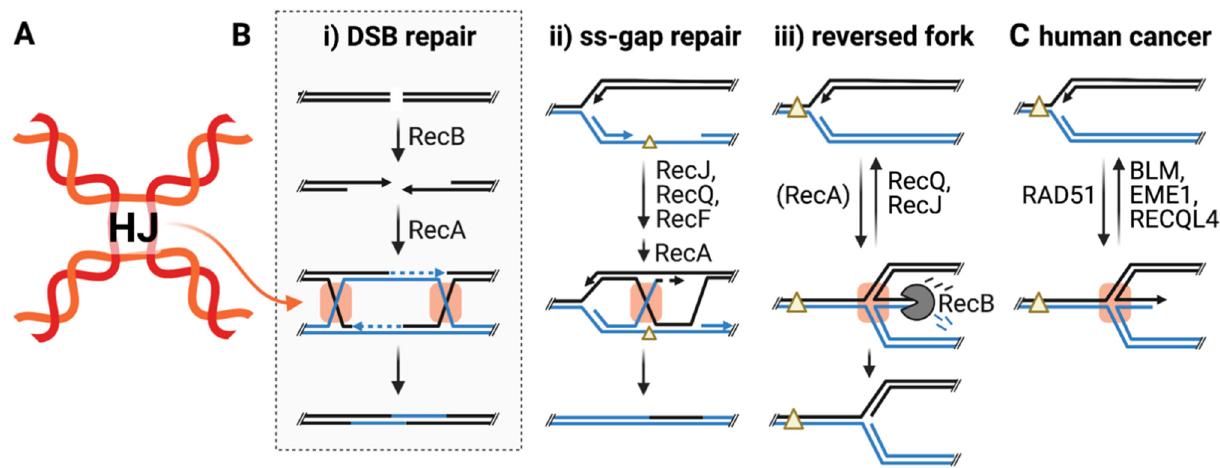
Figure 1. Holliday junction structure and formation. ( A ) An X-shaped Holliday junction (HJ). ( B ) Three pathways of HJ formation, highlighting key components of each pathway. HJs are highlighted by orange boxes. Close parallel lines, base ‐ paired DNA strands; yellow triangles, replication ‐ blocking DNA damage. Gray box indicates HJ ‐ forming pathway at fragile sites. ( i , ii ) [16]. (DSB repair reviewed [33] ). ( iii ) Replication fork stalling and reversal in E. coli. (RecA) indicates that although reversed forks occur without RecA [31,32] , RecA overproduction induces higher levels of fork reversal [18]. ( C ) Proposed roles [18] of RAD51 in promoting fork reversal or stabilizing reversed forks, and BLM, EME1, and RECQL4 preventing or removing reversed forks. These are suggested, first, by RAD51 orthology to RecA, which promotes reversed forks [18]. Second, the many common cancers that overexpress RAD51 also show strongly correlated upregulation of RNAs of both HJ ‐ resolution proteins (EME1, GEN1) and BLM and RECQL4 homologs of RecQ helicase, which prevents fork reversal, presumably allowing DNA replication [18].